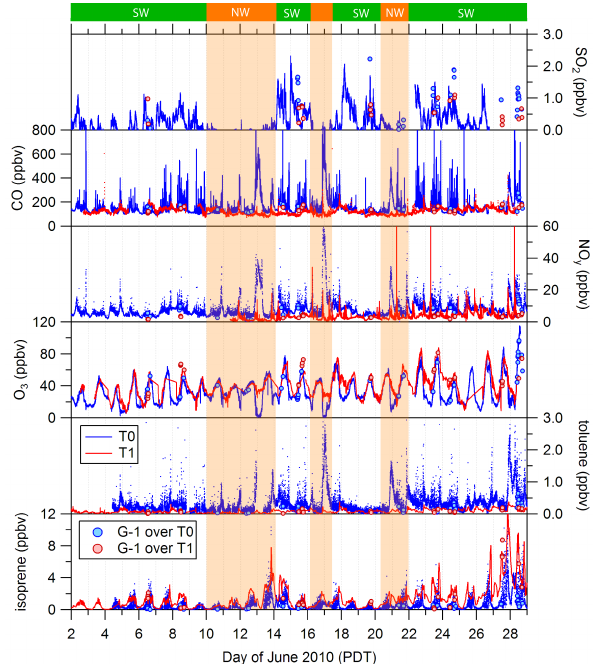
Fig. 6. Comparison of trace gases time series at T0 and T1 ground sites along with observations onboard the G-1 during overpasses at the respective sites. The NO y instrument at the T1 site did not operate until 11 June and the SO 2 instrument at the T0 site did not operate on 27–28